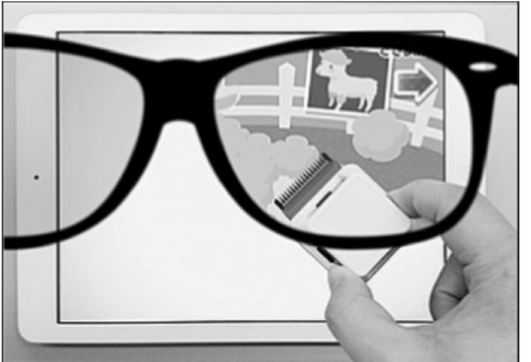
Figure 3. Appearance of the Occlu-pad. Only the right eye can see the image of the tablet terminal, while the left eye